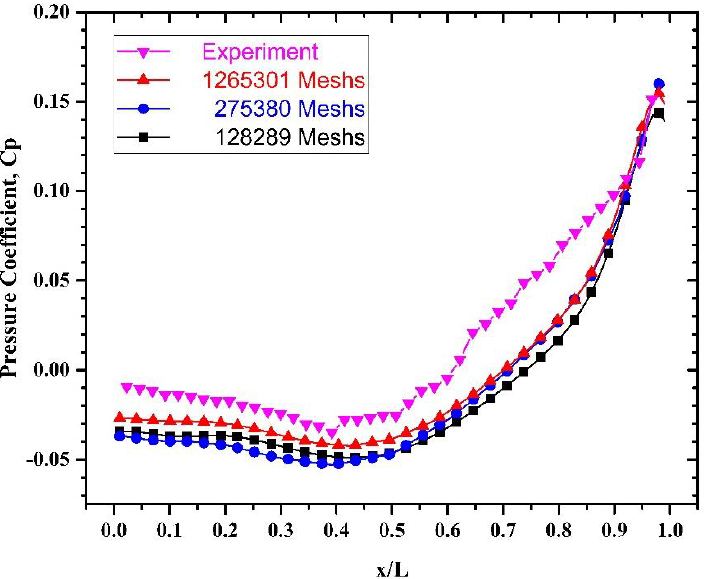
Figure 5. Comparison of pressure coefficient with experiment result of Mesalhy et al. [21].